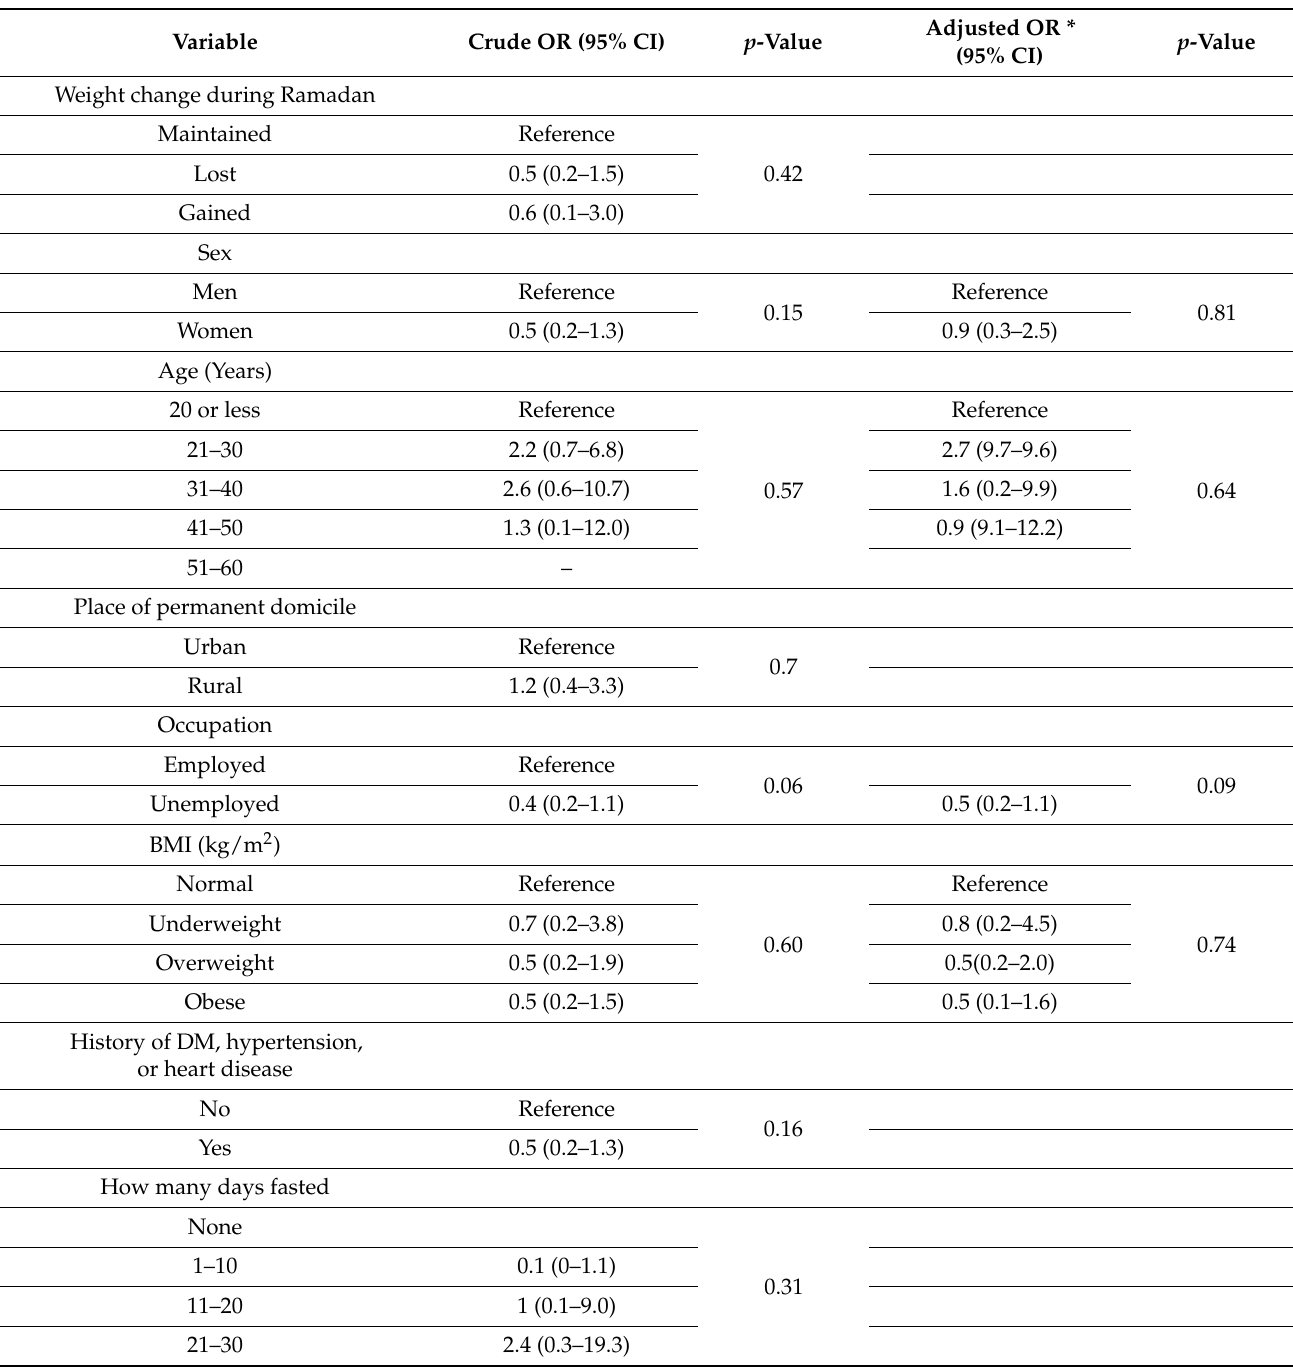
Table 4. Binary logistic regression showing crude and adjusted ORs for factors associated with health state during